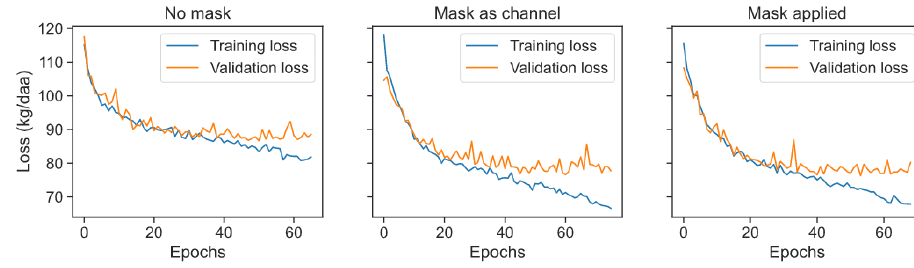
Figure 14. Training and validation loss for the hybrid CNN.